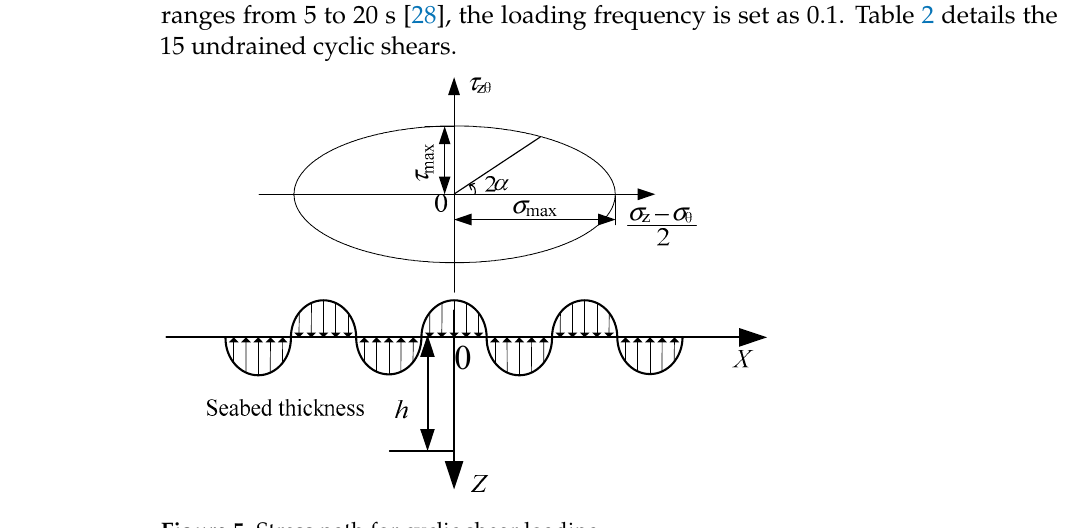
Figure 5. Stress path for cyclic shear loading. Table 2. Undrained cyclic shear